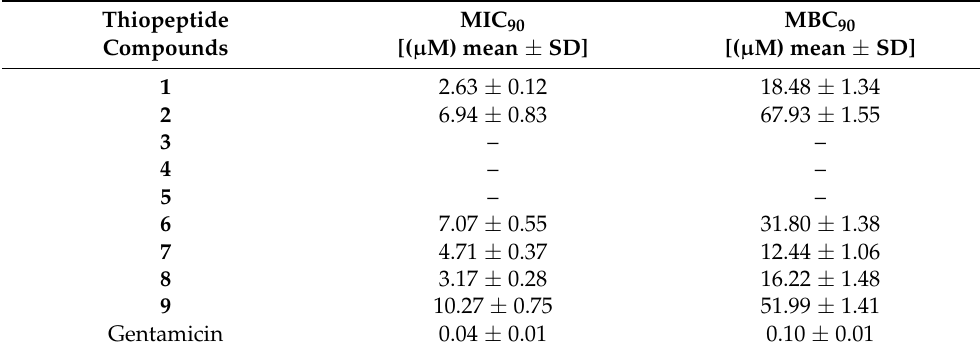
Table 3. Biological activities of compounds 1 – 9 and positive control gentamicin against Staphylococcus aureus Rosenbach (ATCC ®